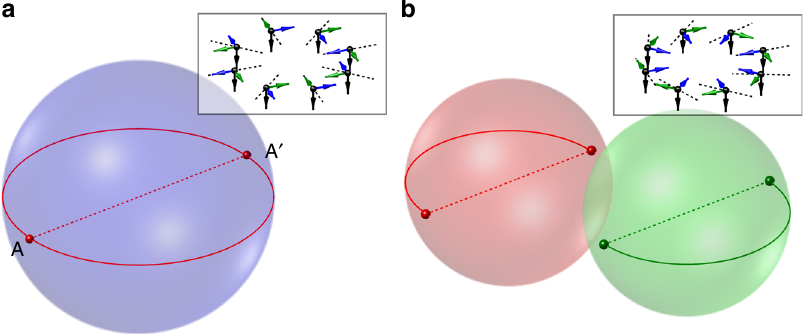
Fig. 2 Contractible and non-contractible loops in SO(3). a Points inside and on the surface of the sphere represent elements of SO(3), with diametrically opposite points (e.g. A and A ′ ) on the surface corresponding to the same element. The contractible loop on the surface of the sphere corresponds to a vortex with 4 π winding that is continuously deformable into the vortex-free state. Such deformation amounts to enacting the Dirac belt trick. b The decay of the non-singular vortex into two separated singular line defects is represented by the emergence of two loops in distinct copies of the SO(3) sphere. Each loop is closed by virtue of the identi fi cation of A and A ′ and cannot be contracted to a point on its own. The insets show the orientation of the ferromagnetic order parameter in real space corresponding to the points on the contractible ( a ) and non-contractible ( b ) loops, respectively. Each orthonormal triad is speci fi ed in terms of its spin direction (black arrows) and two other mutually orthonormal vectors (green and blue), with an axis of rotation given by a dashed